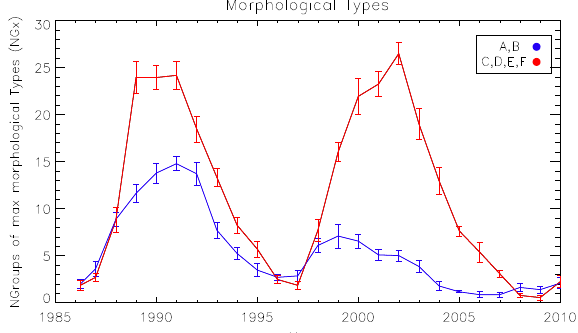
Fig. 6. Evolution of the number of small sunspot groups of McIntosh types A or B (blue curve) and of large groups containing at least one large spot, i.e., types C, D, E and F (red curve) over cycles 22 and 23. Each group was counted once at its maximum development. While large groups appear in equal numbers over both cycles, the number of small groups drops by a factor >2 in cycle 23, in particular after 2000.